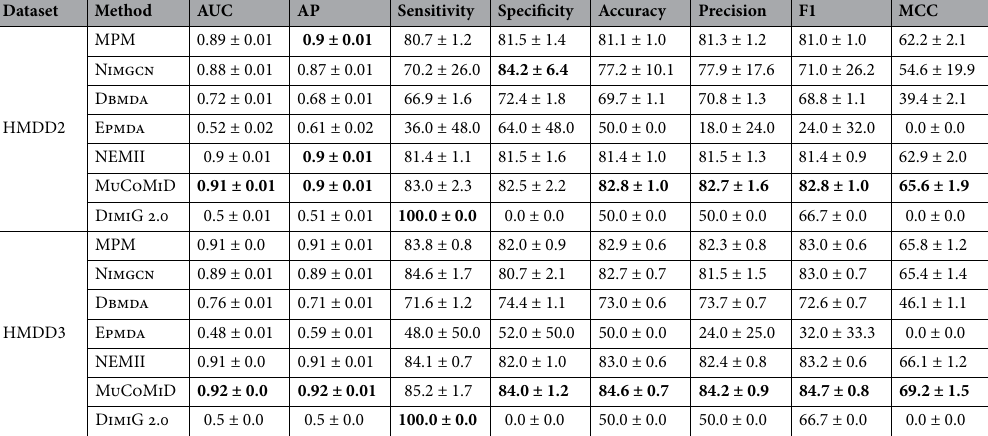
Table 4. Results for 5-fold cross-validation on the Hmdd2 and Hmdd3 datasets.